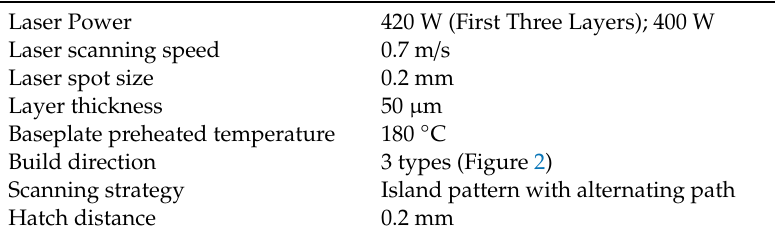
Table 1. Selective laser melting (SLM) process parameters given in fabricating tensile test